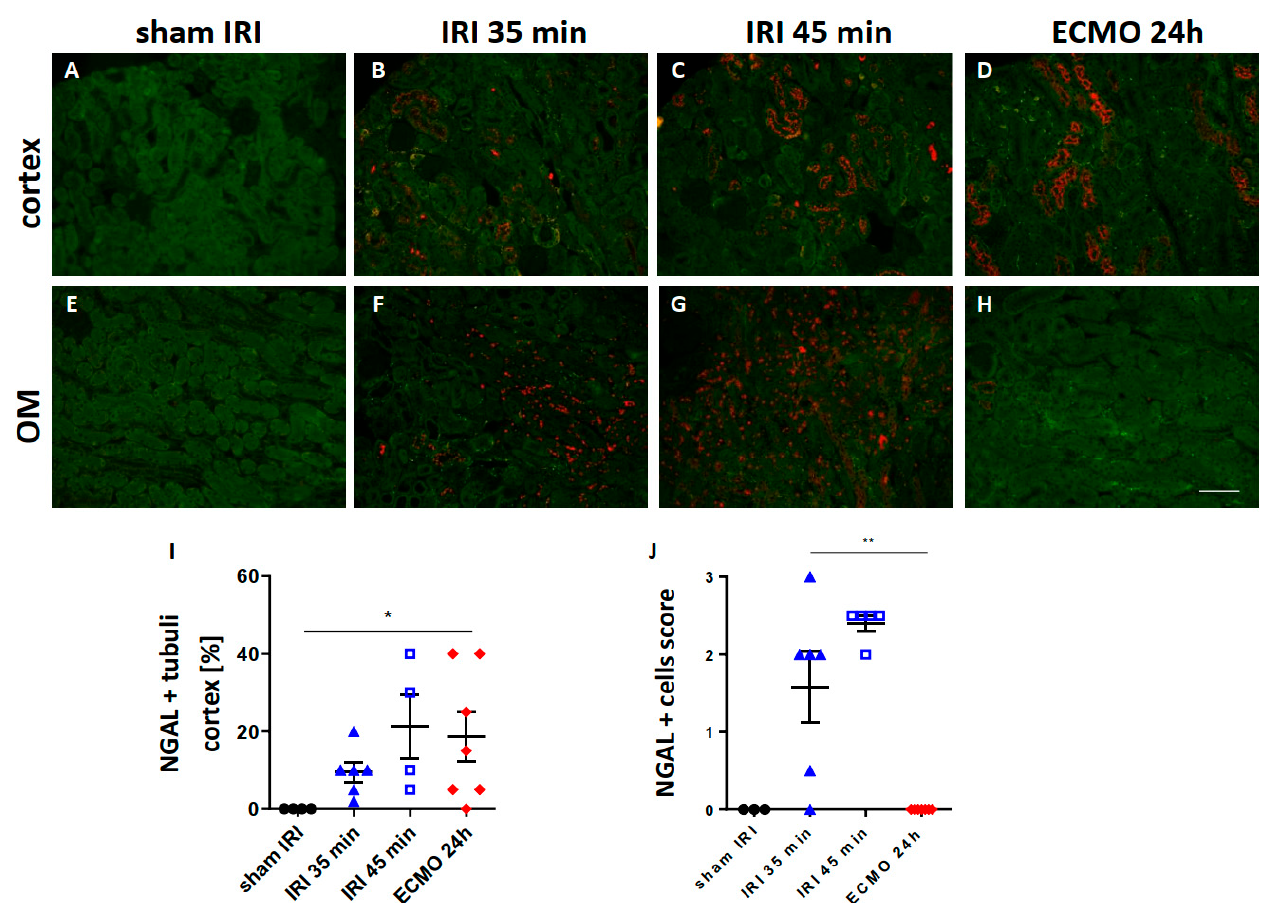
Figure 1. Renal injury marker NGAL in the kidney after moderate and severe renal IRI compared with ECMO. The renal cortex (upper row) and outer medulla (lower row) of NGAL-stained kidney sections are shown 24 h after moderate ( B , F ) and severe ( C , G ) renal IRI and 24 h ( D , H ) after ECMO. The NGAL staining signal is shown in red, tubular autofluorescence in green. Sham-IRI mice and sham-ECMO mice had no significant tubular NGAL expression and sham-IRI control is shown for convenience ( A , E ). Scoring of tubular NGAL expression is shown for the renal cortex in ( I ) and the semi-quantitative scoring of NGAL-expressing cells in the outer medulla (OM) is shown in ( J ). ECMO and severe renal IRI both caused enhanced tubular NGAL expression in the renal cortex ( C , D , I ). In the outer medulla which is most vulnerable to hypoxia increased NGAL-expressing cells were found after moderate ( F ) and severe ( G ) renal IRI which were absent in ECMO-treated mice ( H ). N = 4–7 mice each group are shown. * p < 0.05, ** p < 0.01. Scale bar 100 µm.